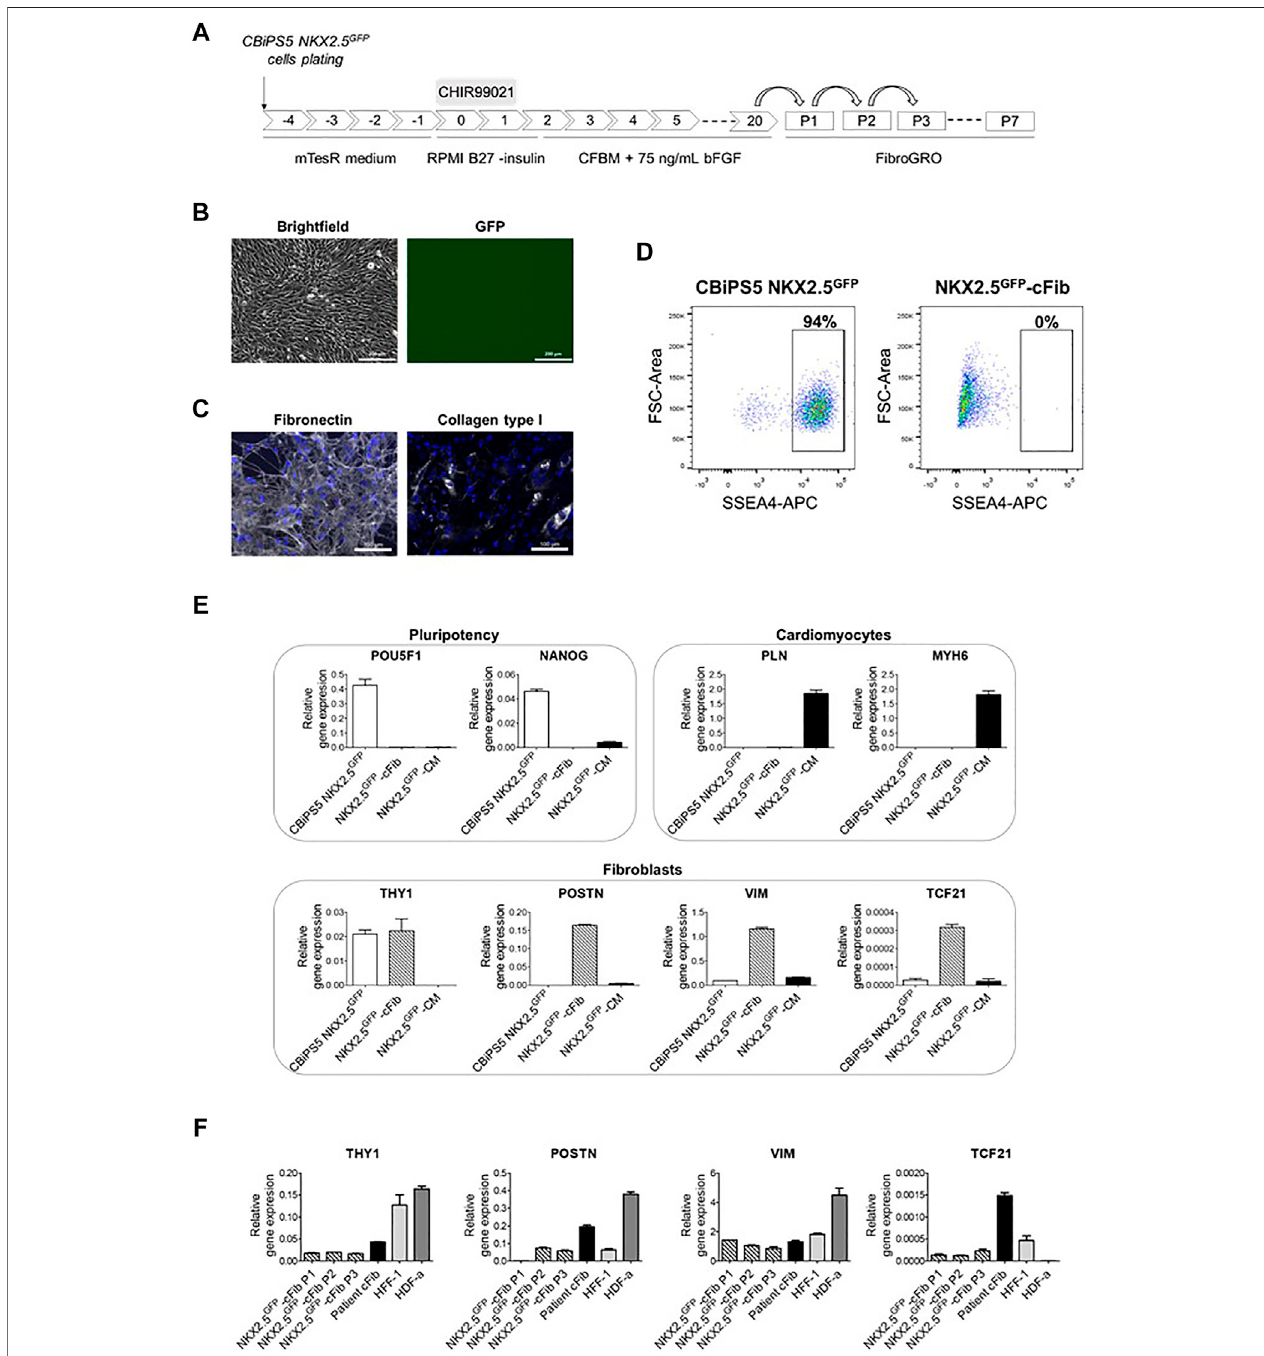
FIGURE 3 | Characterization of NKX2.5 GFP -cFib. (A) Scheme of the fi broblast differentiation protocol used for the generation of NKX2.5 GFP -cFib derived from the CBiPS5 NKX2.5 GFP cell line. (B) Bright fi eld and GFP images obtained from CBiPS5 NKX2.5 GFP -cFib under in vivo fl uorescence microscopy. Scale bars, 200 µm (C) Immunostaininganalysisof fi bronectin(inwhite)andcollagentypeI(inwhite)inNKX2.5 GFP -cFib.Nuclei:DAPI.Scalebars,100 µm (D) DotplotdiagramsofSSEA4 + cells obtained by fl ow cytometry in CBiPS5 NKX2.5 GFP cells and NKX2.5 GFP -cFib. (E) Gene expression analysis of pluripotency (OCT4 and NANOG), cardiomyocyte (PLN and MYH6) and fi broblast (THY1, POSTN, VIM and TCF21) speci fi c genes in NKX2.5 GFP -cFib, CBiPS5 NKX2.5 GFP cells and CBiPS5 NKX2.5 GFP -derived CM (NKX2.5 GFP -CM). (F) Gene expression analysis of fi broblast-speci fi c markers (VIM, POSTN, TCF21 and THY1) in NKX2.5 GFP -cFib at passages 1, 2 and three and in patient-derived cFib, HFF-1 and HDF- α fi broblast cell lines. Mean ± SD represented of three technical replicates is represented.